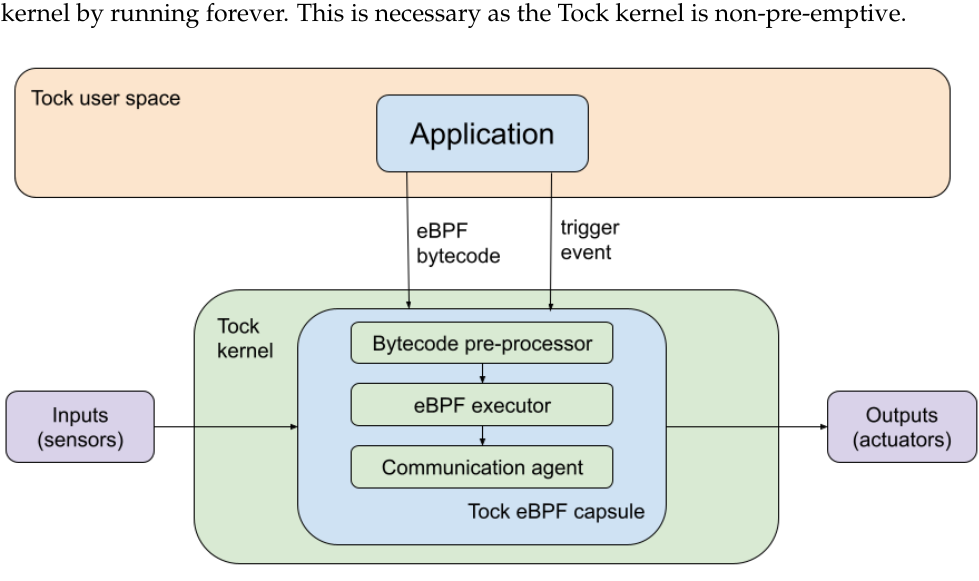
Figure 3. The proposed system